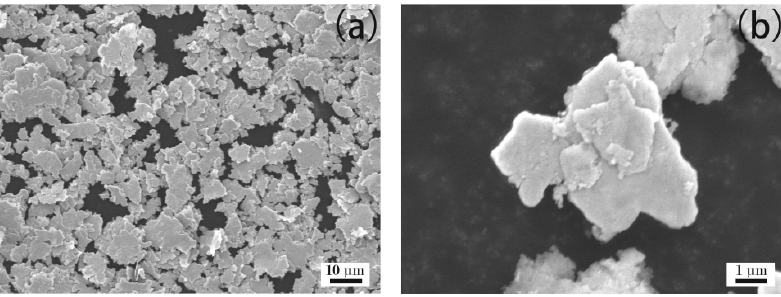
Figure 3. SEM images of Ag flakes. ( a ): aggregates of Ag flakes; ( b ): magnification image of Ag flakes.